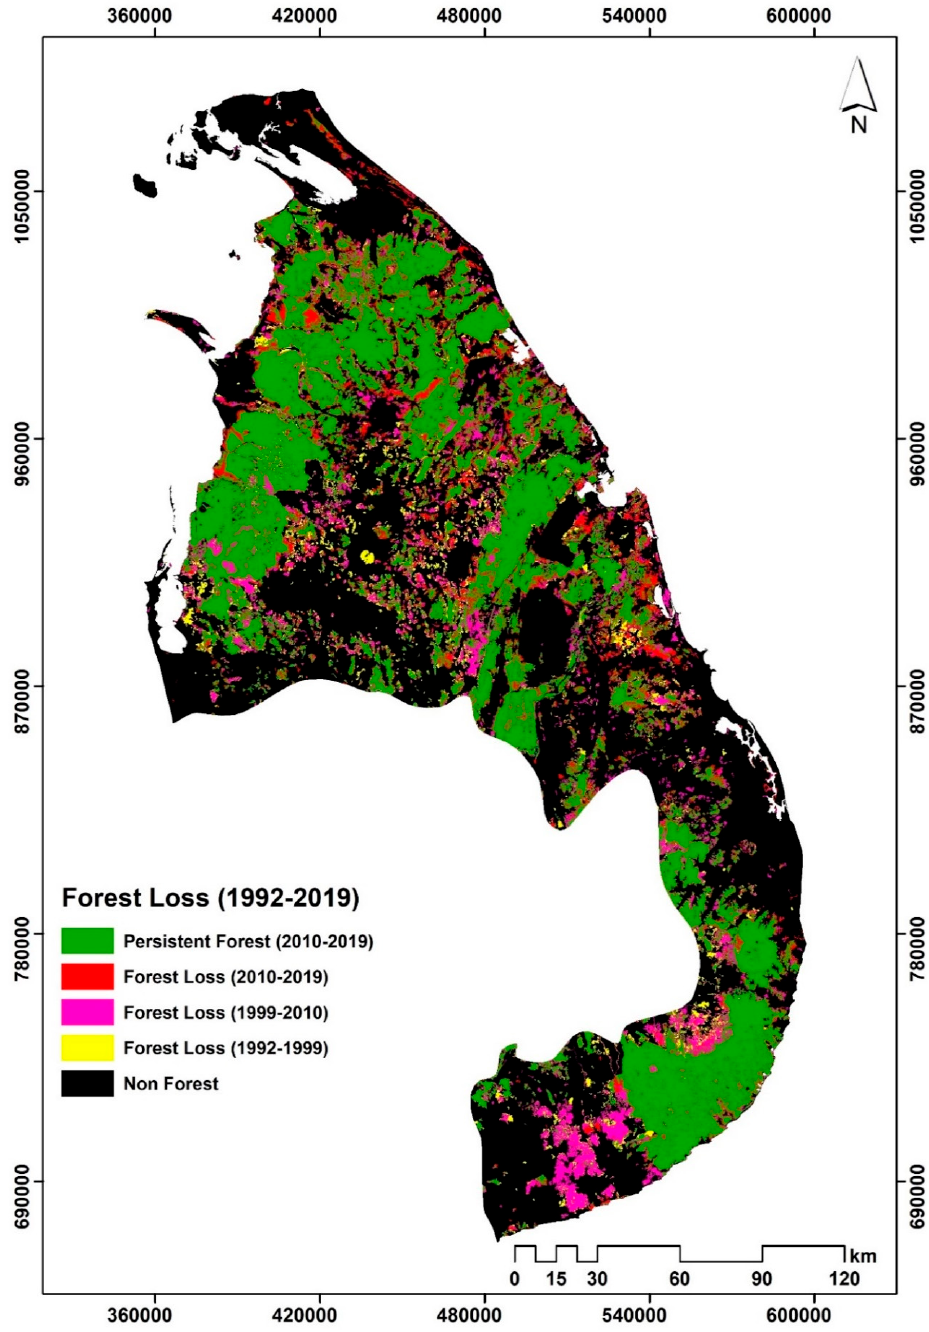
Figure A2. Overall forest loss in the DZ, Sri Lanka from 1992 to 2019. Table A1. Error matrix for the classified 2019 forest cover